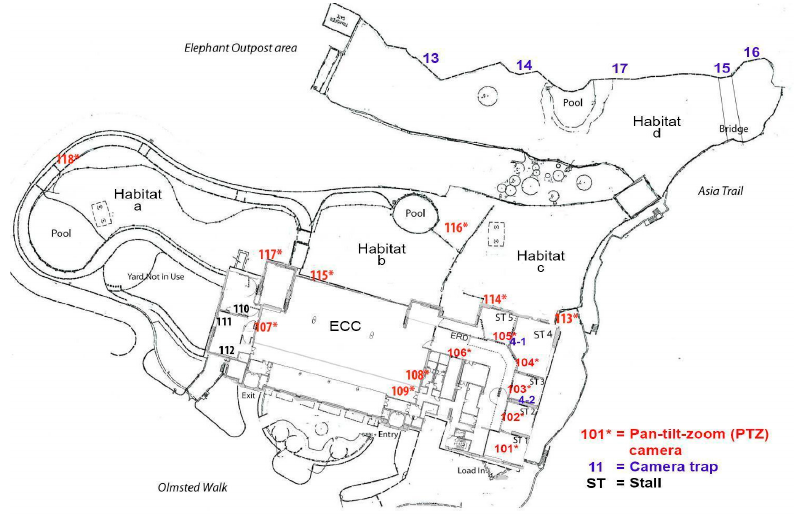
Figure 1. Locations of Pan-tilt-zoom (PTZ) cameras for Genetec closed-circuit system (marked in red) and camera traps (marked in blue) throughout the exhibit and stalls (ST) at the NZP. ECC refers to a large indoor Elephant Community Center with a sand floor, large pool and various feeding devices and enrichment structures and ERD is the elephant restraint device, used for training elephants for husbandry and medical procedures.